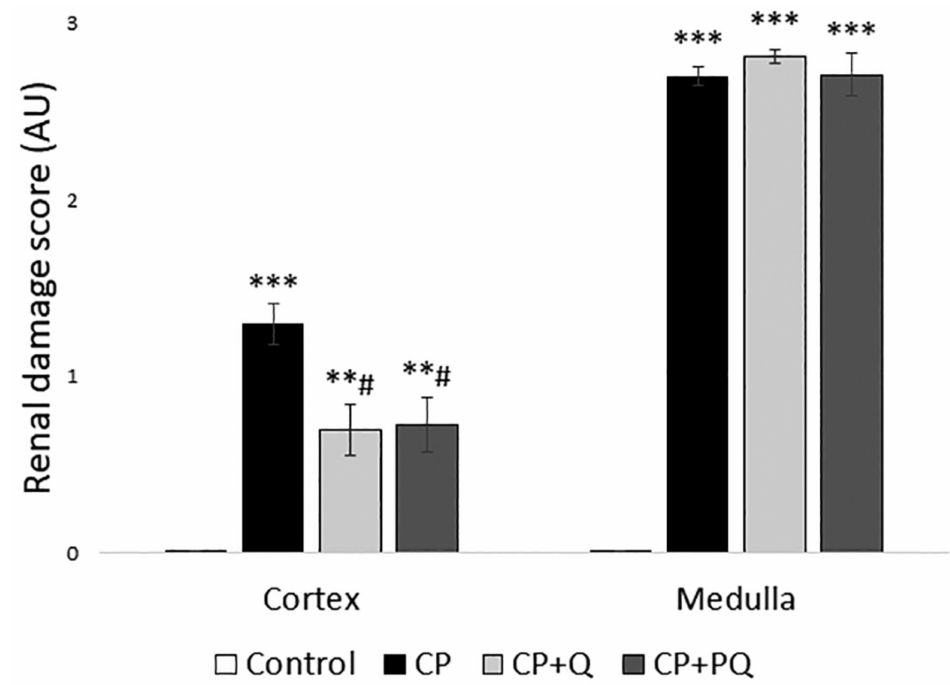
Figure 5. Renal damage quantification. Values are expressed as the mean ± SEM ( n = 5 images × 3 rats per group). ** p < 0.01; *** p < 0.001 vs. Control group. # p < 0.05 vs. CP group. CP: cisplatin (6.5 mg/kg, i.p.) on day 3; CP + Q: quercetin (50 mg/kg, i.p.) for 9 days and cisplatin (6.5 mg/kg, i.p.) on day 3; CP + PQ: P-quercetin (100 mg/kg, i.p.) for 9 days and cisplatin (6.5 mg/kg, i.p.) on day 3. AU: arbitrary